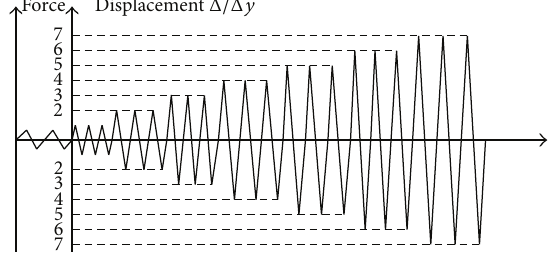
Table 3: Comparisons of the energy